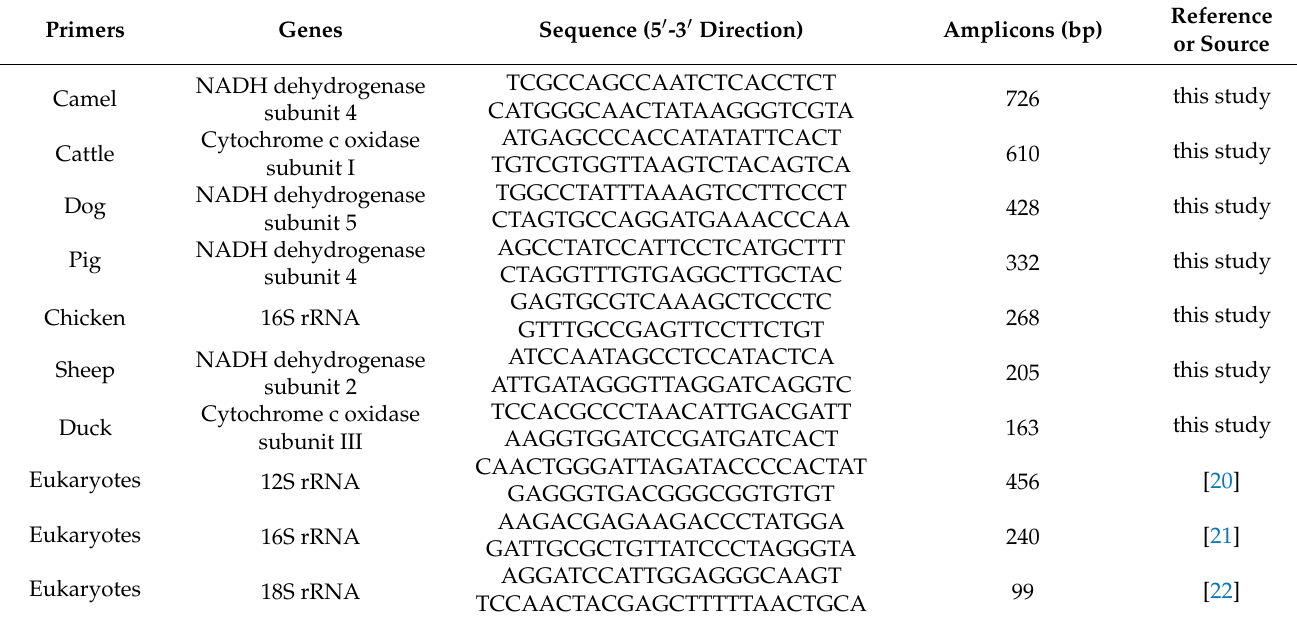
Table 1. Primers were synthesized by Shanghai Sangon Biological Engineering Technology & Services Co., Ltd. (Shanghai, China). Table 1. Oligonucleotide primers for meat species used in this